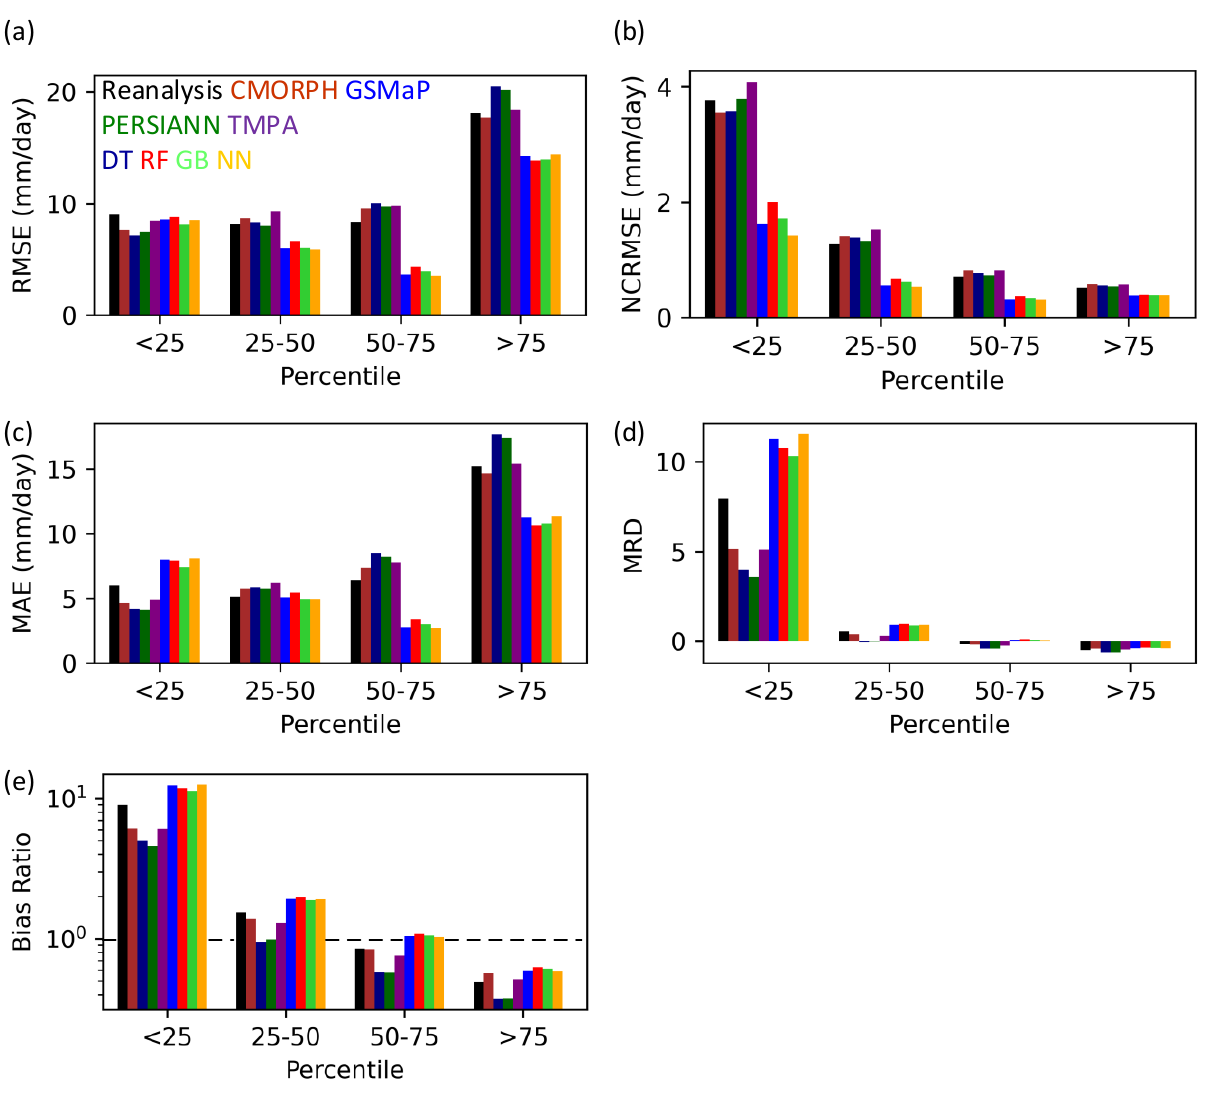
Figure 9. Percentile-based comparison of RMSE ( a ), NCRMSE ( b ), MAE ( c ), MRD ( d ), and BR ( e ) between input models and different machine learning algorithms on the test dataset. Total number of samples in test set was 10,620; thus, each of the four percentile ranges contain 2655 samples. The 0th, 25th, 50th, 75th, and 100th percentile values are 0.03, 3.8, 8.5, 15.2, and 124 mm/day, respectively. The preferred value for BR (=1) is indicated by a black dashed line.